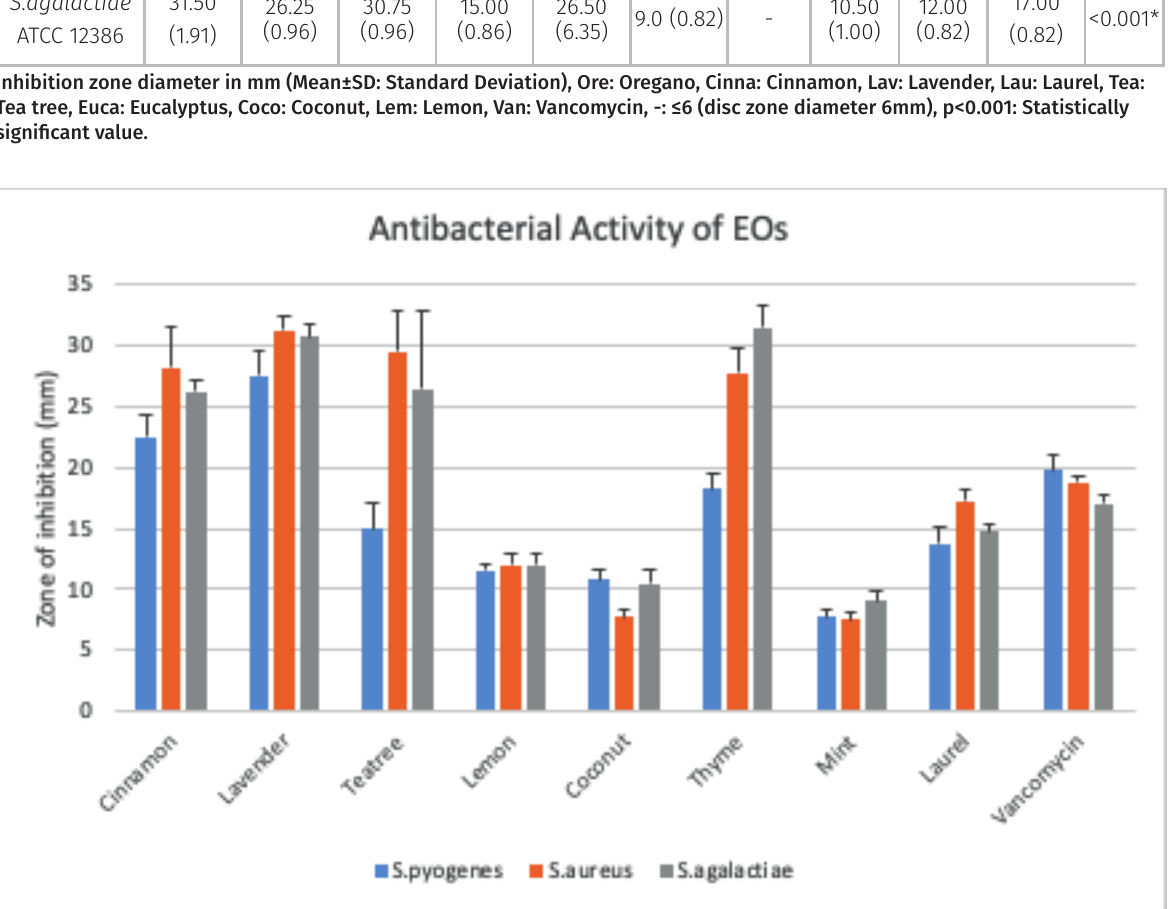
Figure 1. Antibacterial activity of analysed EOs. Vancomycin (30µg/disc) was used as a positive control for inhibition assay. P value less than 0.001 is statistically signifi